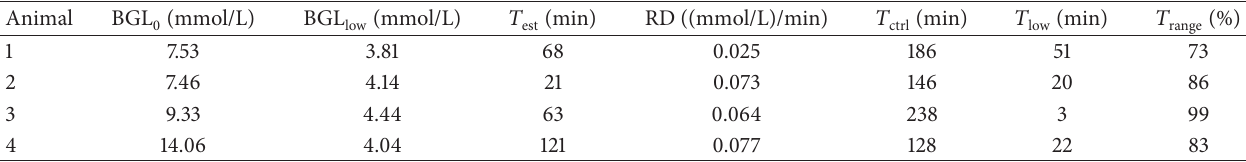
: the blood glucose level at the time of the first insulin bolus; BGL : the 0 low : time to establish glycemic control from the first insulin bolus until the blood est ; 𝑇 : time with glycemic control from blood est ctrl : total time with blood glucose levels below 4.5mmol/L during 𝑇 ; 𝑇 : low ctrl range . ctrl